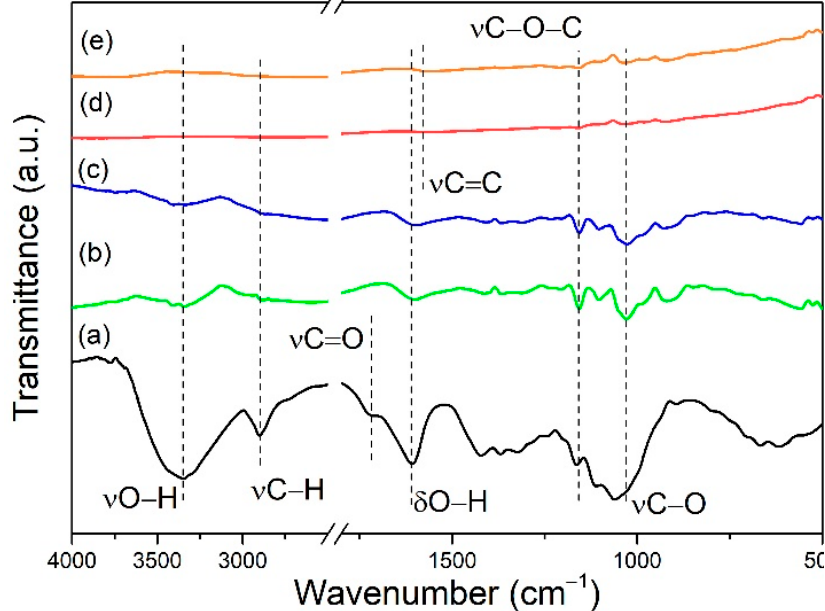
Figure 4. FTIR spectra of CNF ( a ), CNF–CNT ( b ), CNF–GnP ( c ), CNT ( d ) and GnP ( e ). To optimize the representation, the region of 2500–1800 cm − 1 is omitted.